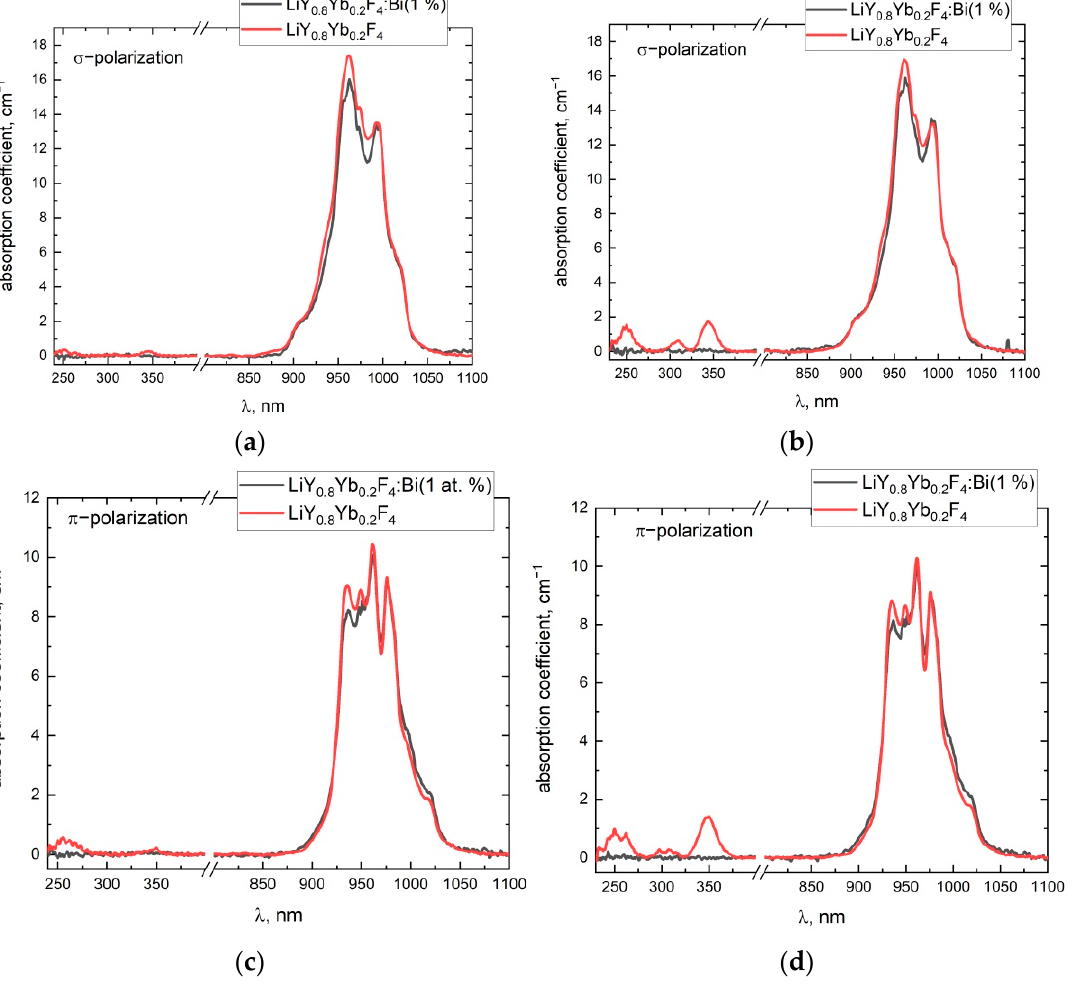
Figure 2. Polarized absorption spectra of two different parts of the LiY 0.8 Yb 0.2 F 4 and LiY 0.8 Yb 0.2 F 4 :BiF